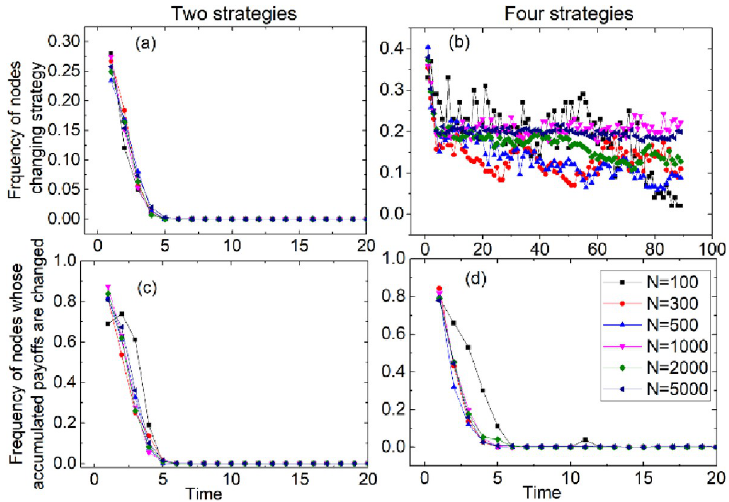
Fig 1. The frequencies of nodes who change strategies in each round in games with {C, D} strategy (Fig 1A) and {C, D, WSLS, ZD} strategy (Fig 1B). The frequencies of nodes whose accumulated payoffs are changed in each round in games with {C, D} strategy (Fig 1C) and {C, D, WSLS, ZD} strategy (Fig 1D).